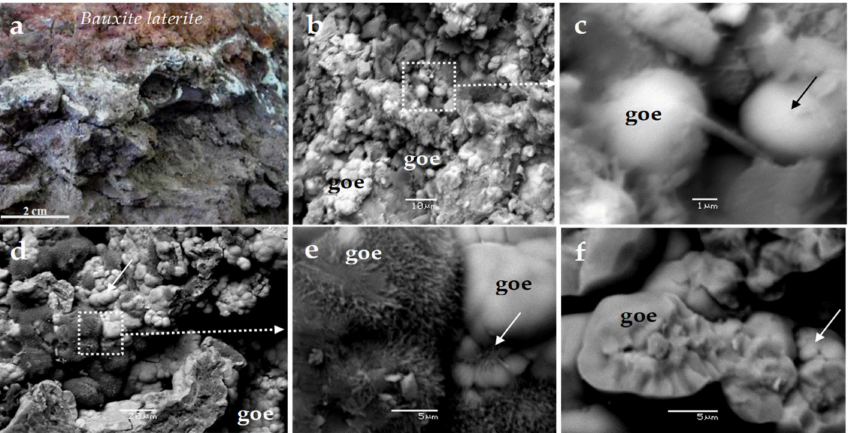
Figure 4. Field photograph ( a ) and BSE images ( b – f ) from unpolished parts of the Nissi–Patitira bauxite laterite ore. Highly tectonized reddish to deep red laterite gradually grading to gray, pinkish white, and pale green laterite ores along fractures and towards the carbonate basement limestones ( a ); goethite (goe) of different morphologies, with sub-micron spherulitic aggregates being the dominant microtextures ( b – f ); close-up view morphology of goethite ( c , e ) of the ( b , d ) corresponding, resembling bacterial cells coated by goethite (black and white